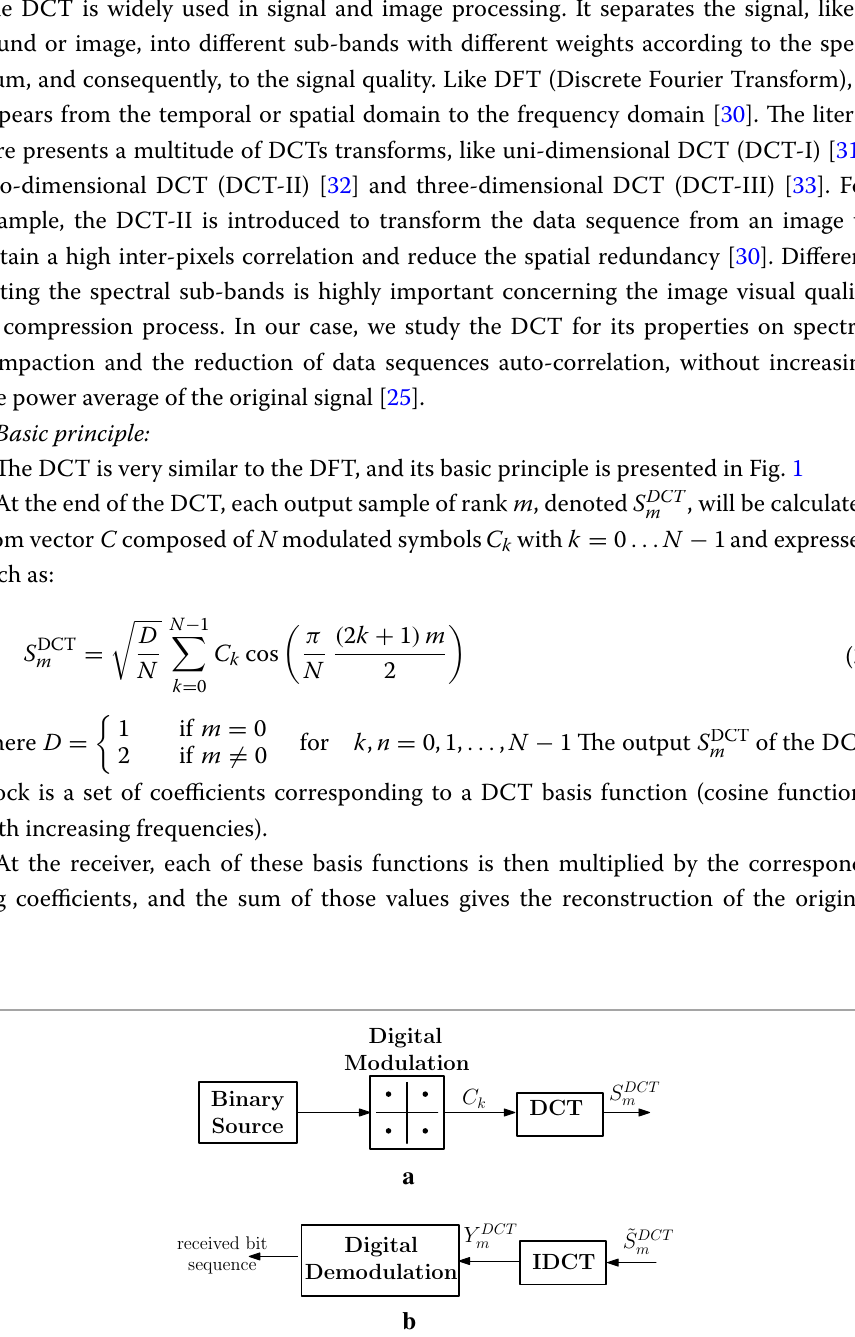
Fig. 1 Block scheme of DCT a transmitter, b